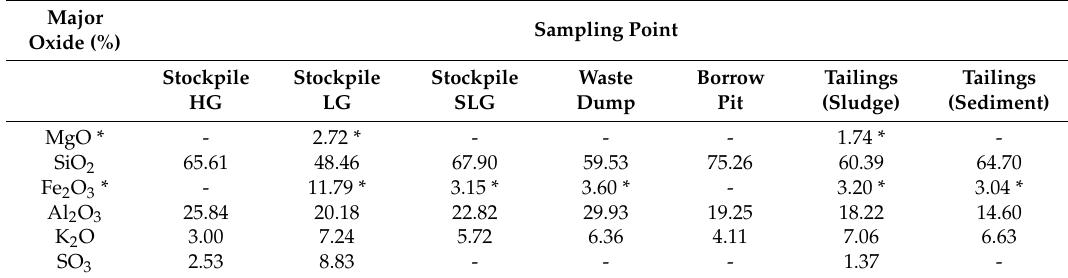
Table 4. Chemical composition of soil, sludge and sediment of the mining waste at Selinsing Gold Mine. Major Oxide